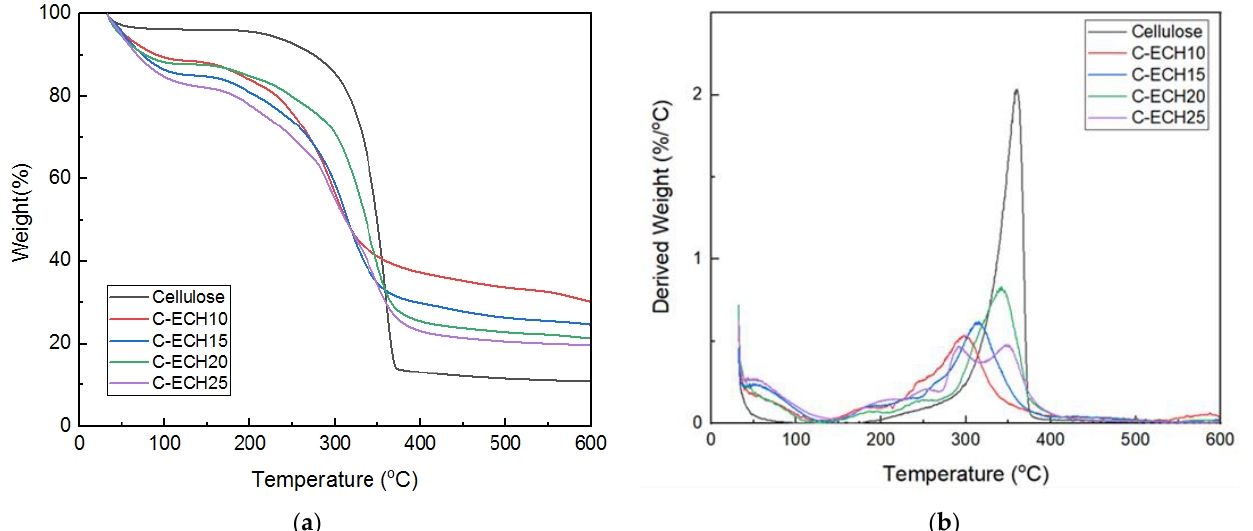
Figure 4. ( a ) TG and ( b ) DTG analysis of the cellulose and cellulose bioplastic samples at various ECH